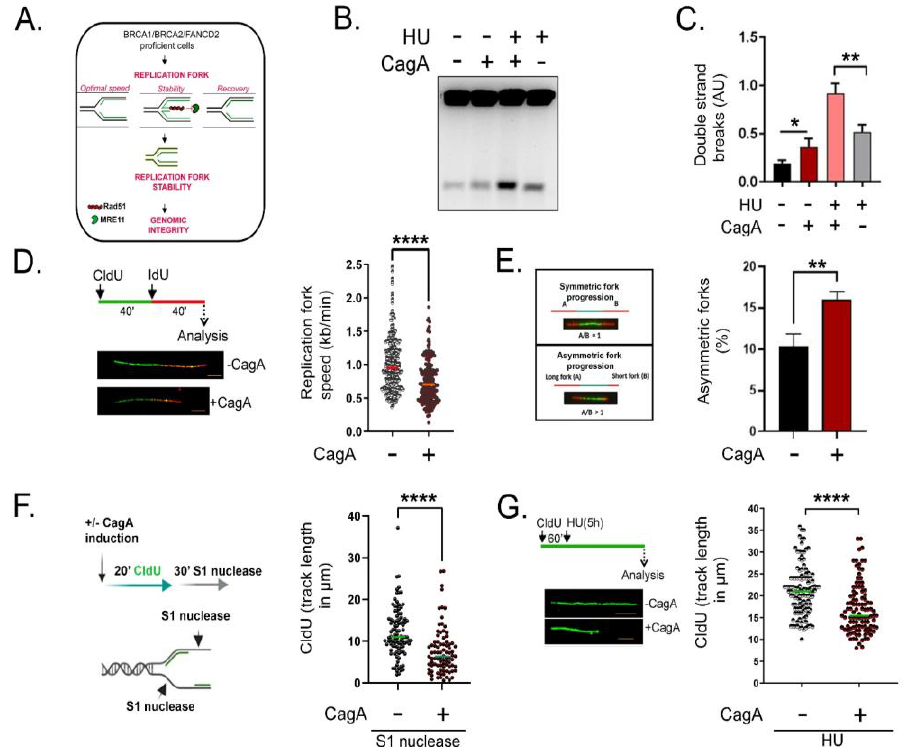
Figure 3. FA genes down-regulation following CagA expression reduces replication fork speed, accumulate single strand gaps, and compromise replication fork stability ( A ). Model showing the requirement of FA/HR factors for the maintenance of replication fork speed, stability, and re-start concertedly translating into fork stabilisation and genomic integrity. ( B ) Pulsed field gel electrophoresis image showing DNA DSBs in the presence or absence of CagA. Cells were optionally supplemented with HU (0.2 mM HU for 8 h). ( C ) Quantification of Double-Strand Breaks (DSBs) intensity (AU) ( D ) Fork Speed-Fibre Assay Scheme: Cells were exposed sequentially to CldU and IdU for 40 min each. Replication speed was calculated by measuring the CIdU and IdU tract (only connected fibres were considered for the statistical analysis). Scale bar= 5 kb, p = < 0.0001 , Mann–Whitney test, n = 250 fibres each condition. The experiments were performed at least three times. ( E ) (Left) Representative image depicting the difference between symmetric and asymmetric replication forks is shown. (Right) Asymmetric forks were measured by dividing the long fork by the short fork. A minimum of 75 fibres were counted for each condition and the percentage was calculated. The experiment was repeated at least thrice to reach similar results. ( F ) S1 nuclease assay scheme—In the presence or absence of CagA, cells were labelled for 20 min with CIdU and subjected to S1 nuclease treatment for 30 min. At least 75 fibres were scored in two independent experiment yielding similar results. ( G ) Fork degradation-Fibre assay scheme: Cells were pulsed labelled with CIdU for 60 min, following which they were exposed to HU (4 mM) for 5 h. Replication fork degradation was calculated at least from 100 fibres for each condition by measuring the median CIdU tract length. The experiment was performed twice and similar results were obtained. Asterisks represent significant